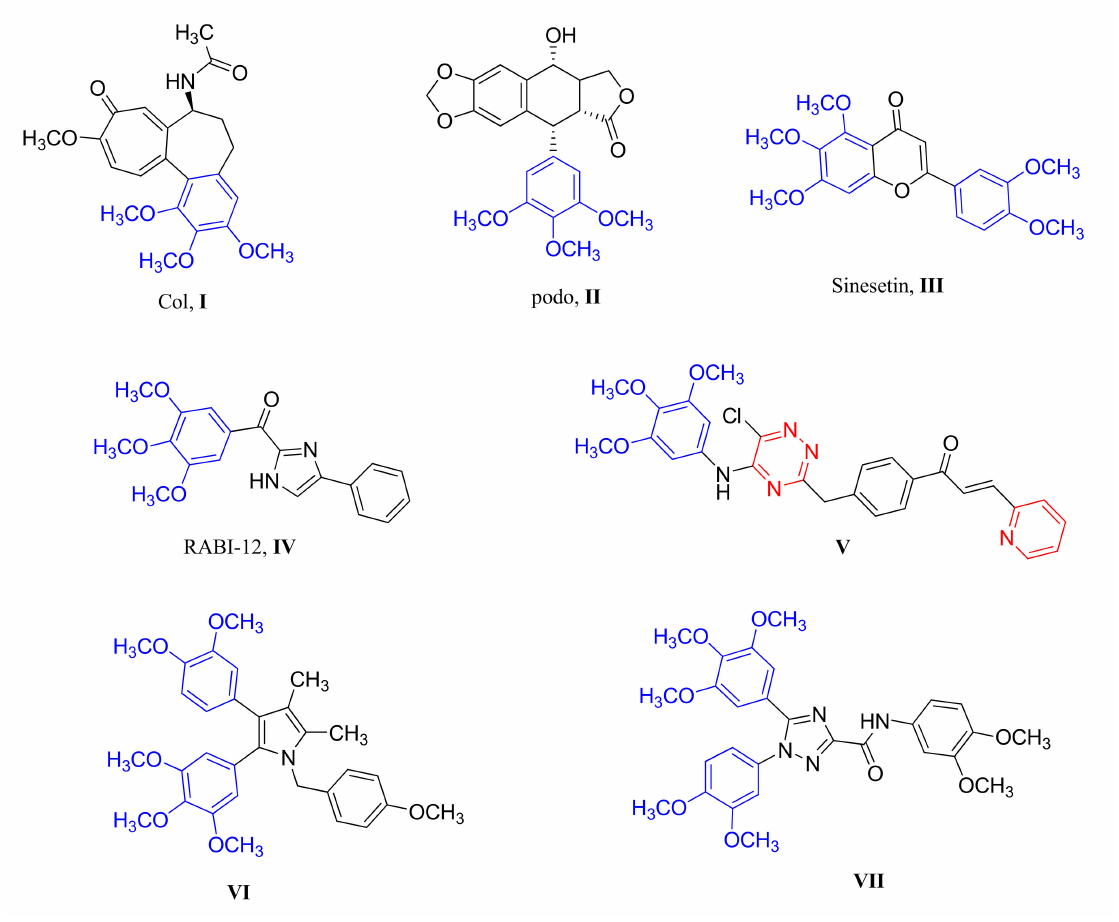
Figure 1. Chemical structure of col I , podo II , Sinensetin III , Imidazole IV , and 1,2,4-triazine V as anti-cancer agents and some reported tubulin polymerization inhibitors, VI and VII